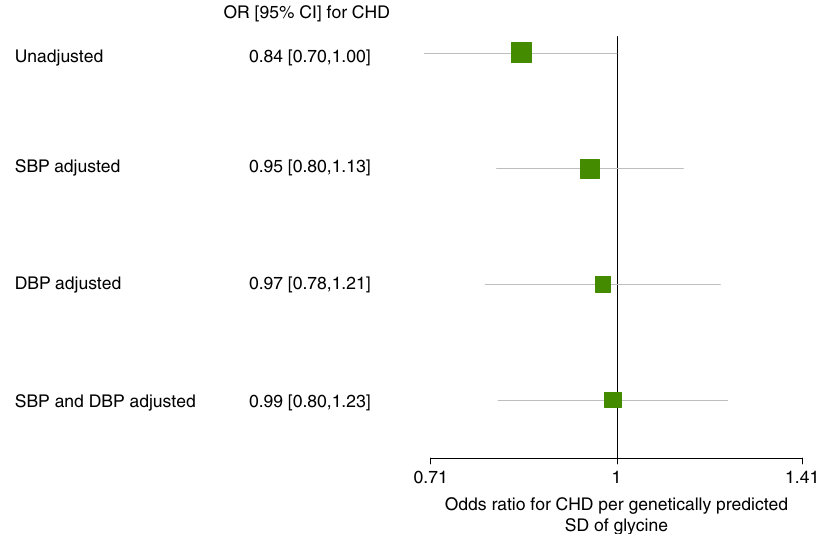
Fig. 7 Forest plot of the odds ratios ± 95% con fi dence intervals for coronary heart disease per genetically predicted standard deviation of glycine, with and without adjustment for blood pressure. CHD: coronary heart disease, DBP: diastolic blood pressure, SBP: systolic blood pressure, SD: standard deviation, CI: con fi dence